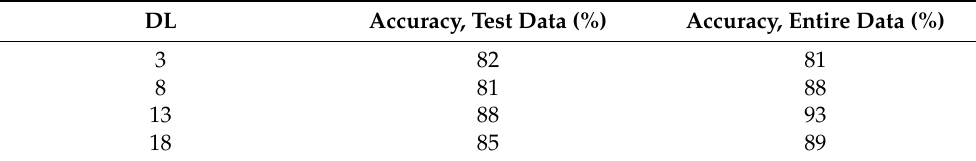
Figure 7. Confusion matrix for model 𝑀 (cid:2869) as target at DLs ( a ) 3, ( b ) 8, ( c ) 13, and ( d ) 18 (see Figure 1b). Table 5. Accuracy results for coupled POD JDA–kernel, Target: M 1 Table 5. Accuracy results for coupled POD JDA–kernel, Target: 𝑀 (cid:2869) .